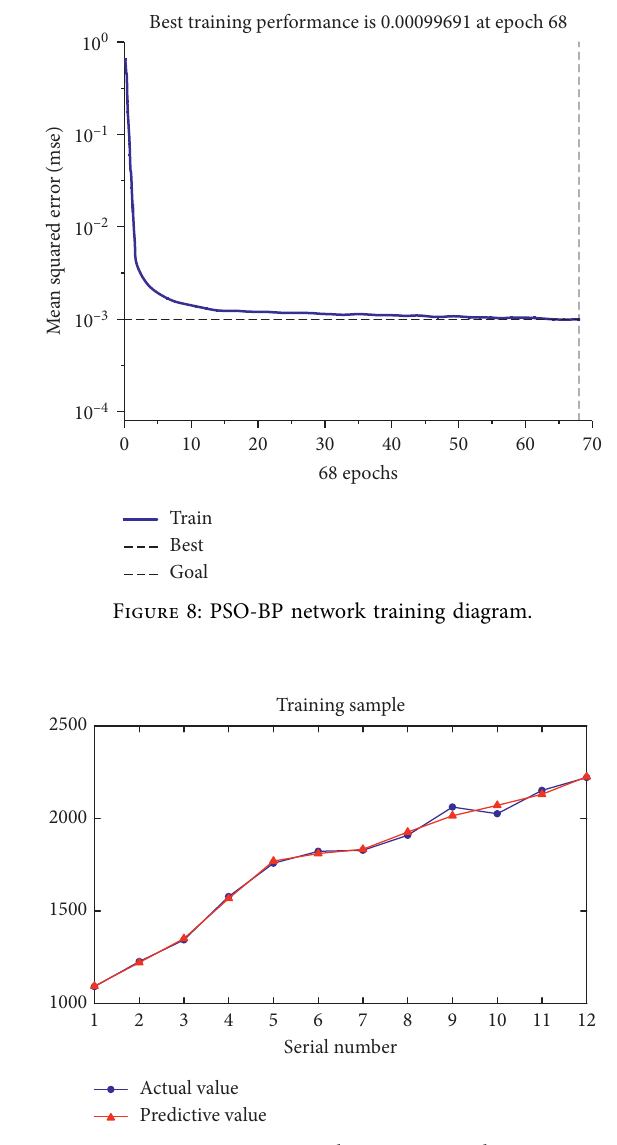
Figure 9: BP network training